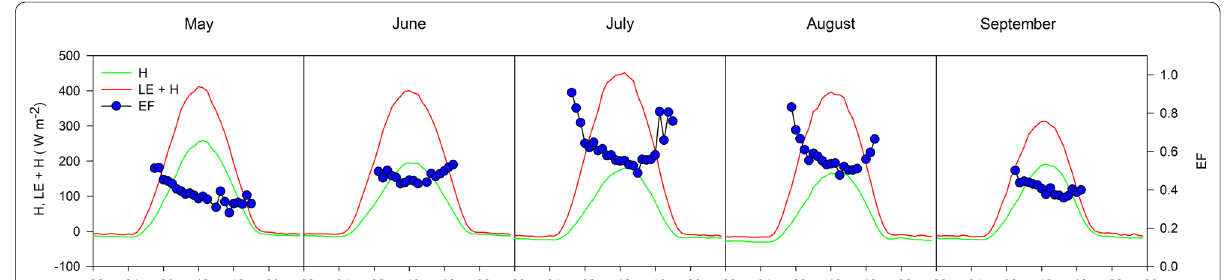
Fig. 2 Monthly diurnal cycles of available energy (LE every half-hour from the fluxes, according to Eq. 1